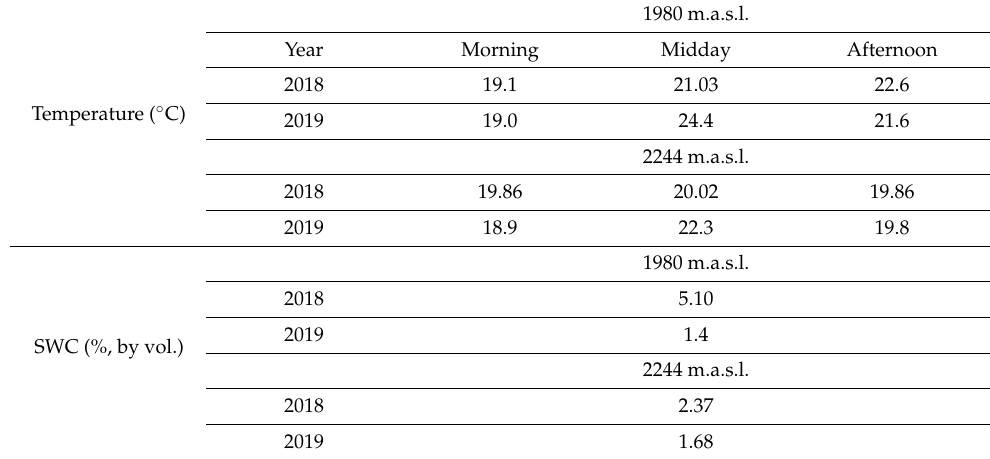
Table 1. Environmental conditions during sample collection for the xanthophyll cycle experiment (July 2018 and 2019). Average topsoil water content (SWC) values are shown only for the highest and lowest sites of the studied elevational gradient from up to the time of sampling for the xanthophyll pigment analyses—Climate Info Source: Spanish Institute of Meteorology,